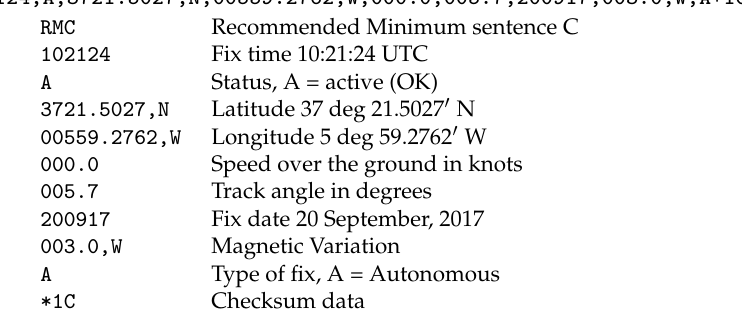
Figure 8. Traditional computer clock model based on a VCO.